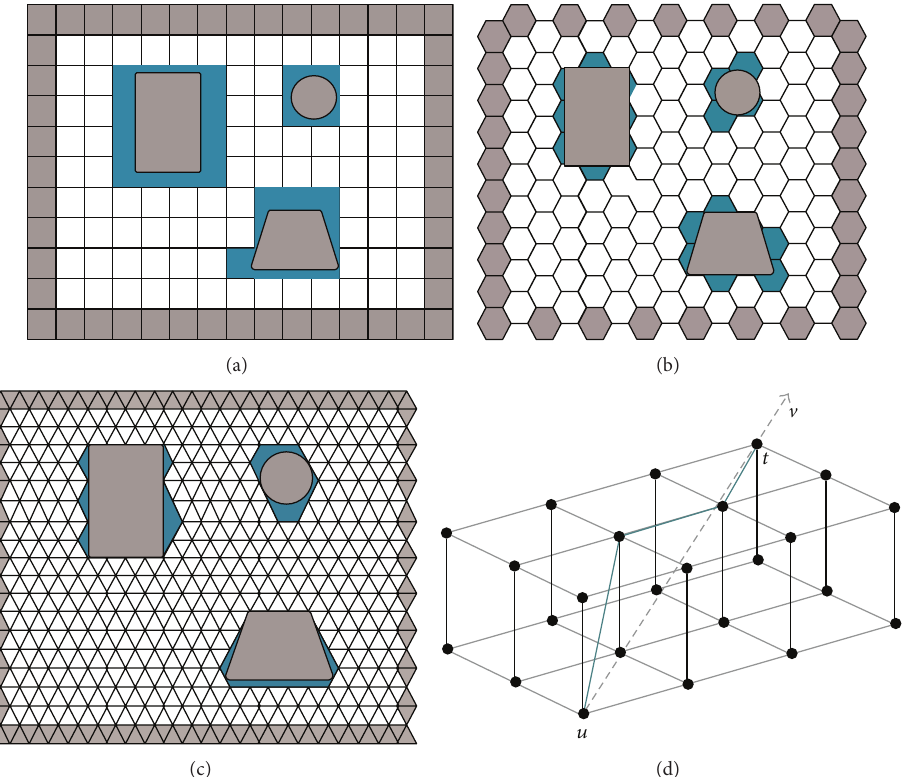
Figure 2: (a) Square grid with three obstacles, (b) hexagonal grid with three obstacles, and (c) triangulation grid with three obstacles and (d) without